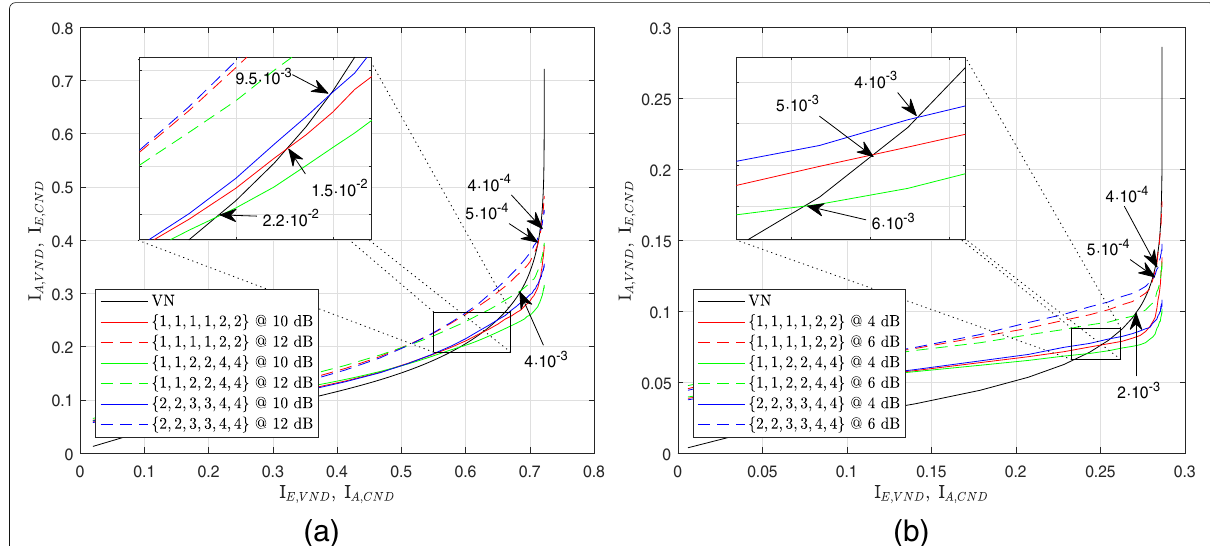
Fig. 6 EXIT chart and predicted BER at the crossing points for different SNR values. a For a non-uniform source with p 0 = 0.8 and the configuration = 1. b For a non-uniform source with p with d ( v ) LDGM